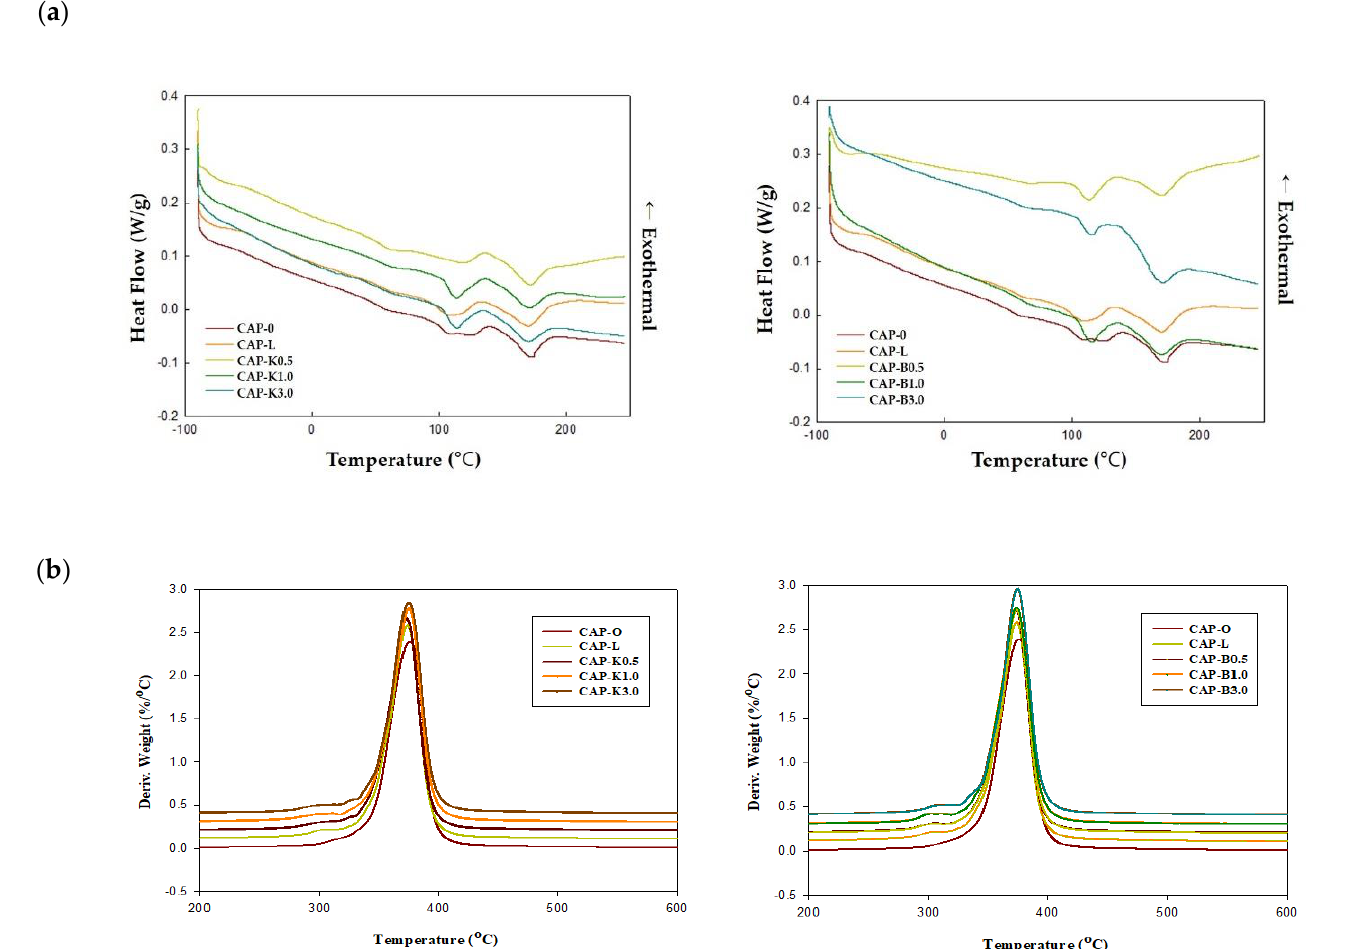
Figure 17. Thermal properties of cellulose acetate propionate–biofiller composites: ( a ) DSC thermo- grams and ( b ) DTG (derivative thermos gravimetry) curves.